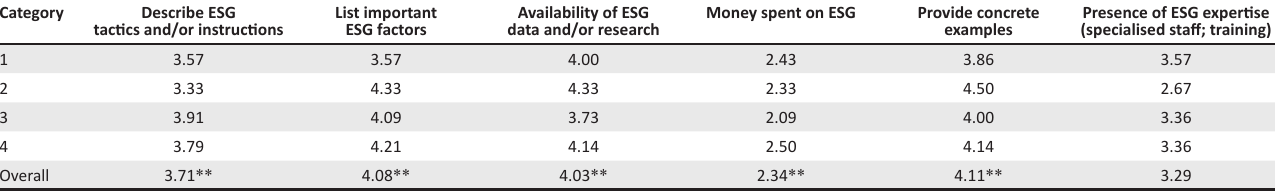
TABLE 5: Relevance of investor abilities or characteristics to environmental, social and governance integration.